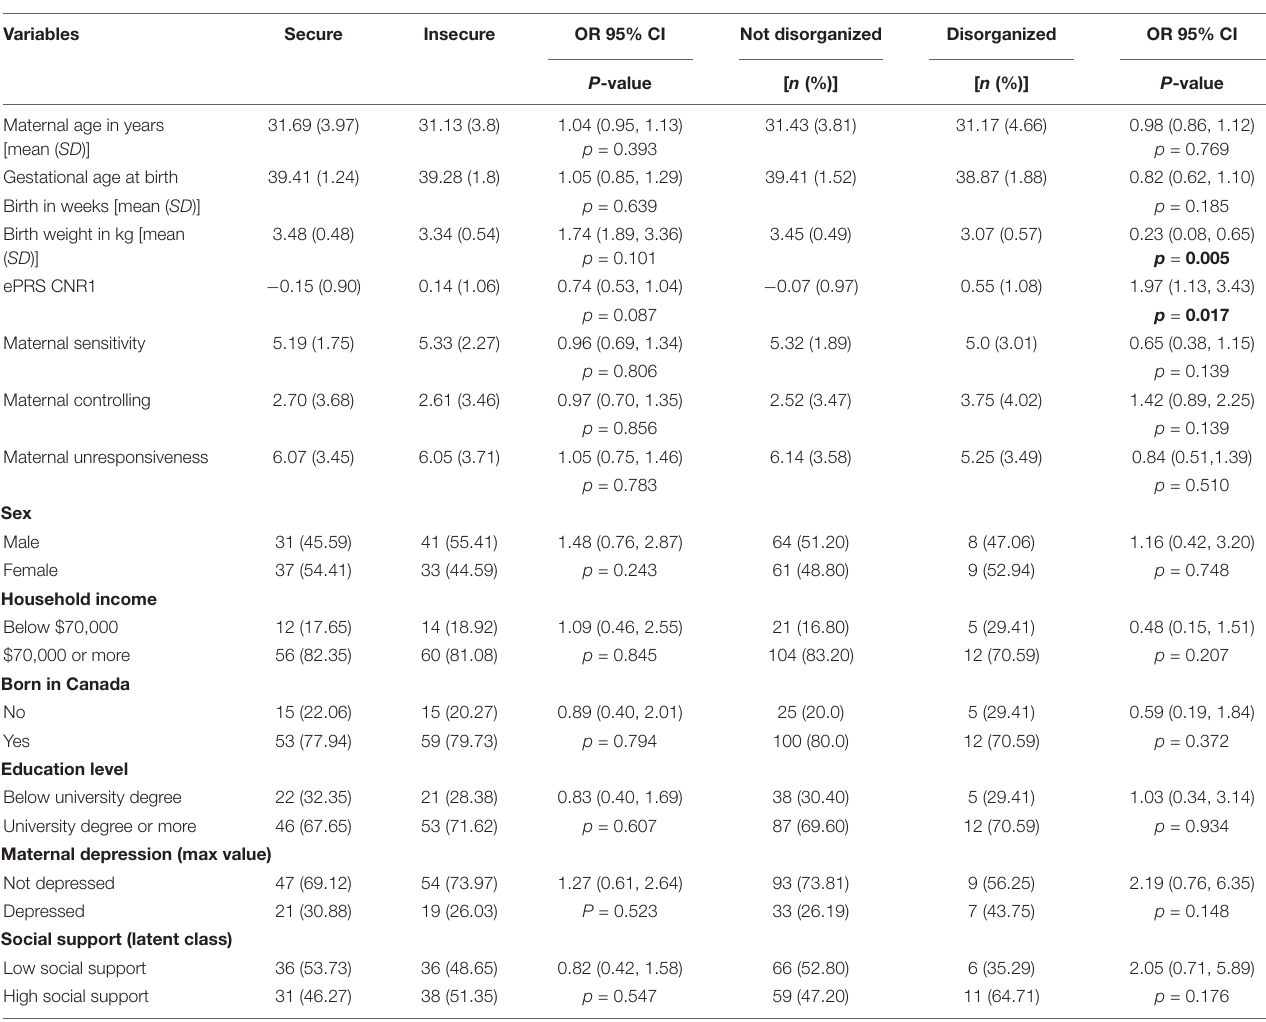
TABLE 2 | Associations between predictors and attachment